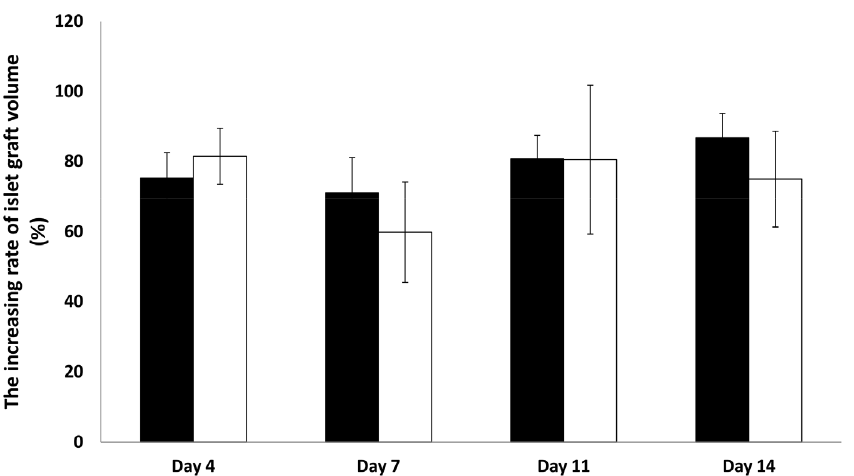
Figure 6. The increasing rate of islet graft volume with and without tacrolimus. The increasing rate (against day 1) of islet graft volume at 4, 7, 11, and 14 days after transplantation in the control group (black bar: n=9) and the tacrolimus-treated group (white bar: n=4) was calculated. All values are expressed as the means 6 SEM.